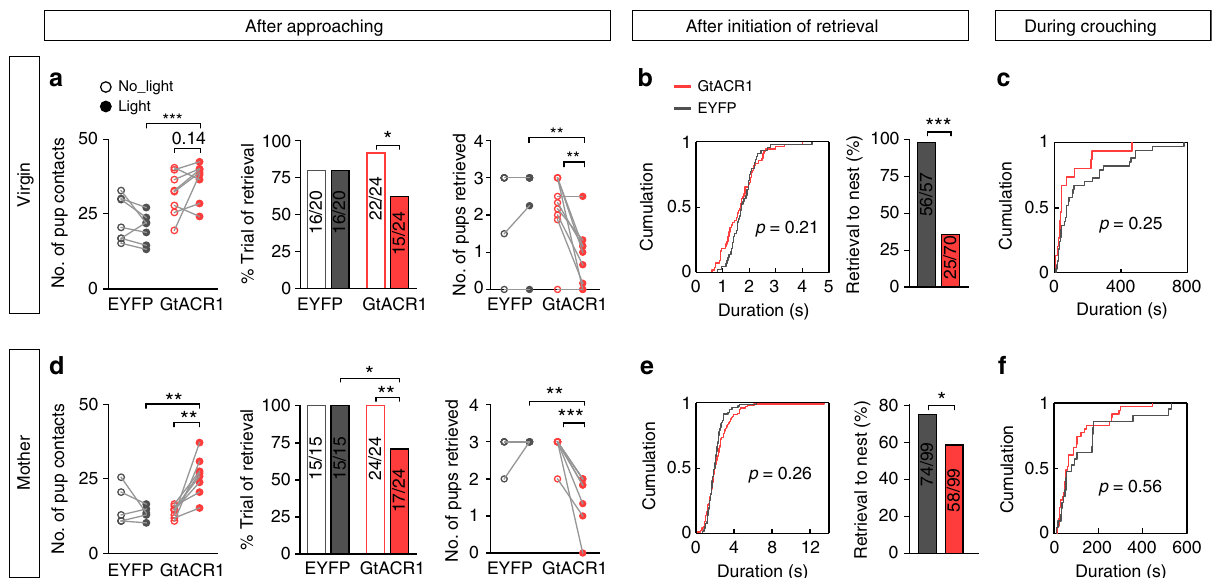
Fig. 9 Optogenetic inhibition of mPOA Esr1 + neurons disrupts pup retrieval in both virgin and lactating females. a In virgin females, light was delivered when animals were within pre-speci fi ed distance to pups, number of pup contacts, percentage of trials with pup retrieval behavior, and number of pups retrieved to the nest were plotted and compared between no-light and light trials for both GtACR1 and control females. N = 7 EYFP and 8 GtACR1. b In virgin females, a 5 s light pulse was delivered after initiation of each retrieval, cumulative distribution of retrieval duration and the percentage of retrieval bouts that brought a pup to the nest were plotted and compared between GtACR1 and control females. N = 3 EYFP and 3 GtACR1. c In virgin females, 10 s light pulses were delivered during crouching, cumulative distribution of crouching duration was plotted and compared between GtACR1 and control females. N = 3 EYFP and 2 GtACR1. d – f In lactating females, light was delivered when animals were within pre-speci fi ed distance to pups ( d ), or a 5 s light pulse was delivered after initiation of retrieval ( e ), or 10 s light pulses were delivered during crouching ( f ), and similar parameters were plotted as in virgin females. In d , N = 5 EYFP and 8 GtACR1; in e , N = 3 EYFP and 6 GtACR1; In f , N = 3 EYFP and 5 GtACR1. In a and d , t test or Wilcoxon rank sum test, left and right, Fisher ’ s exact test, middle. In b and e , ks-test, left, Fisher ’ s exact test, right. * p < 0.05, ** p < 0.01, *** p <